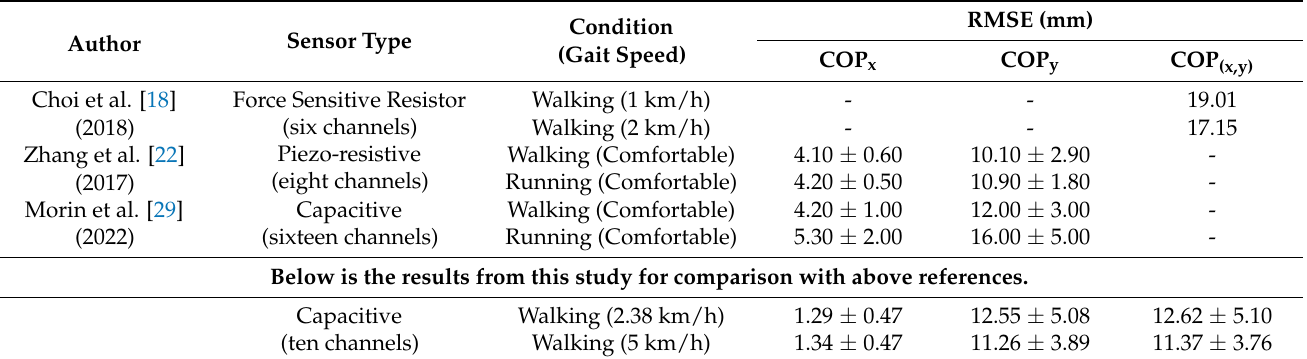
Table 6. Comparison of COP analysis using various types of insole